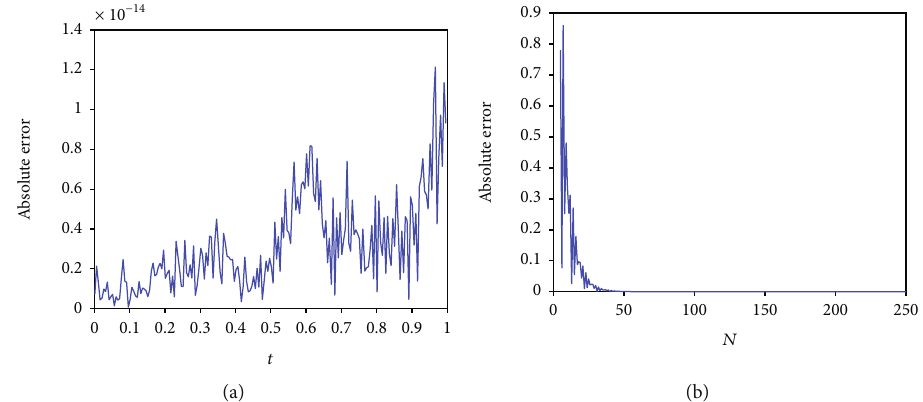
Figure 6: In (a), the error function for t ∈ ½ 0, 1 (cid:2) and β = 1 and in (b), for di ff erent quadrature nodes N and β = 1 for Problem 3 are shown. Table 5: The approximate solutions of ζ using the two numerical schemes N = 240, M = 22 , corresponding to Problem 4.